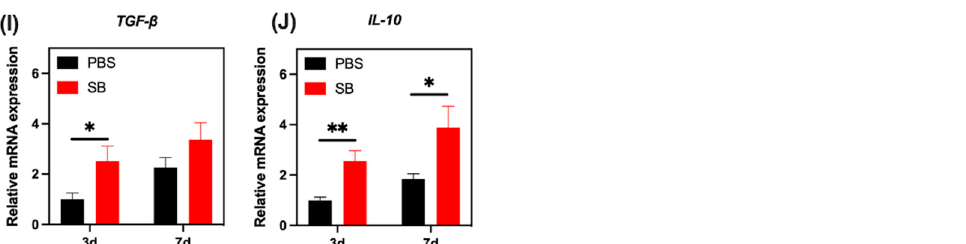
Figure 10. Effects of S. boulardii early intervention on the inflammatory response. The levels of TNF- α ( A ), IL-1 β ( B ), and IL-6 ( C ) in the colon. The levels of TNF- α ( D ), IL-1 β ( E ), and IL-6 ( F ) in serum. The relative mRNA expression of the gene for TLR4 ( G ), NF- κ B ( H ), TGF- β ( I ), and IL-10 ( J ). Values are expressed as means ± SEM, n = 10–12. * p < 0.05, ** p < 0.01. d, day. PBS, rats early intervened with phosphate buffer solution. SB, rats early intervened with S. boulardii . TNF- α , tumor necrosis factor α . IL-1 β , interleukin 1 β . IL-6, interleukin 6. TLR4, toll-like receptor 4. NF- κ B, nuclear factor kappa-light-chain-enhancer of activated B cells. TGF- β , transforming growth factor β . IL-10, interleukin 10.